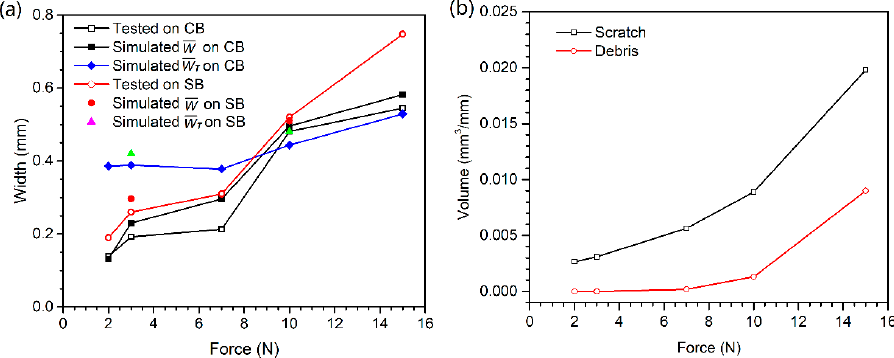
Figure 11. ( a ) Scratch size and ( b ) materials damage as a function of scratching force.